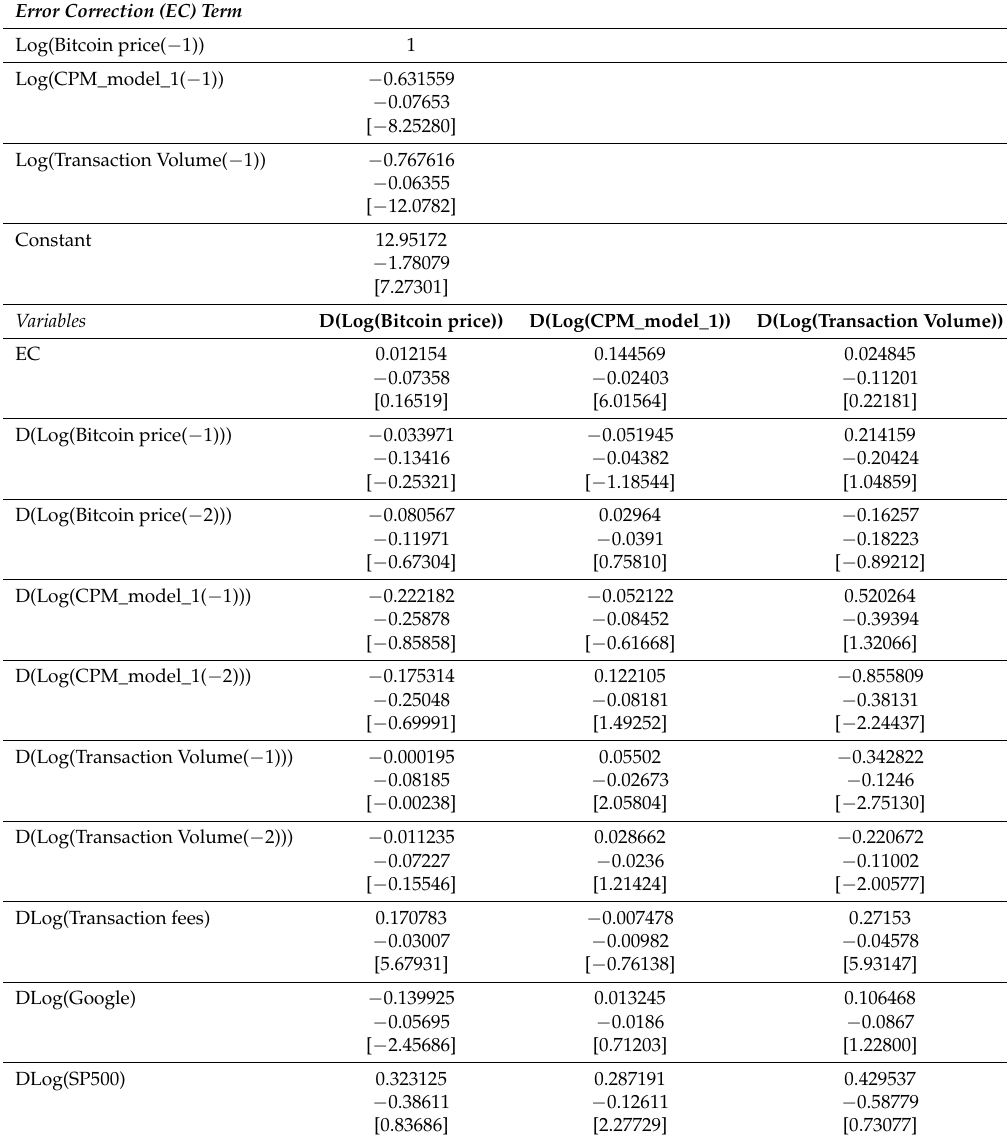
Table A9. VECMX(2) for Log(Bitcoin price), Log(CPM model 1), and Log(Transaction volume), with Log(transaction fees), Log(Google), and Log(SP500) as exogenous variables. Second sample: